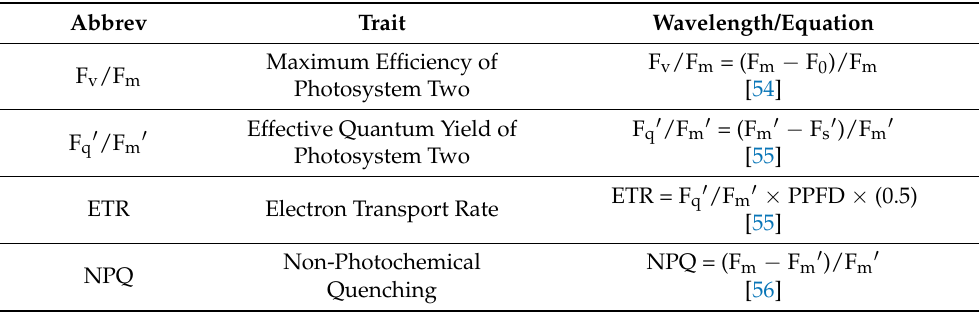
Table 1. List of calculated chlorophyll fluorescence parameters with abbreviations, the equation for calculation, and the reference.